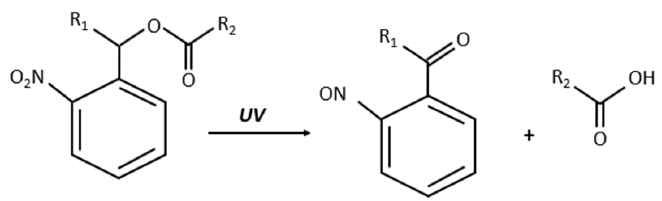
Figure 5. Photo ‐ cleavable o ‐ nitrobenzyl ester irradiated with UV light. Figure 5. Photo-cleavable o -nitrobenzyl ester irradiated with UV